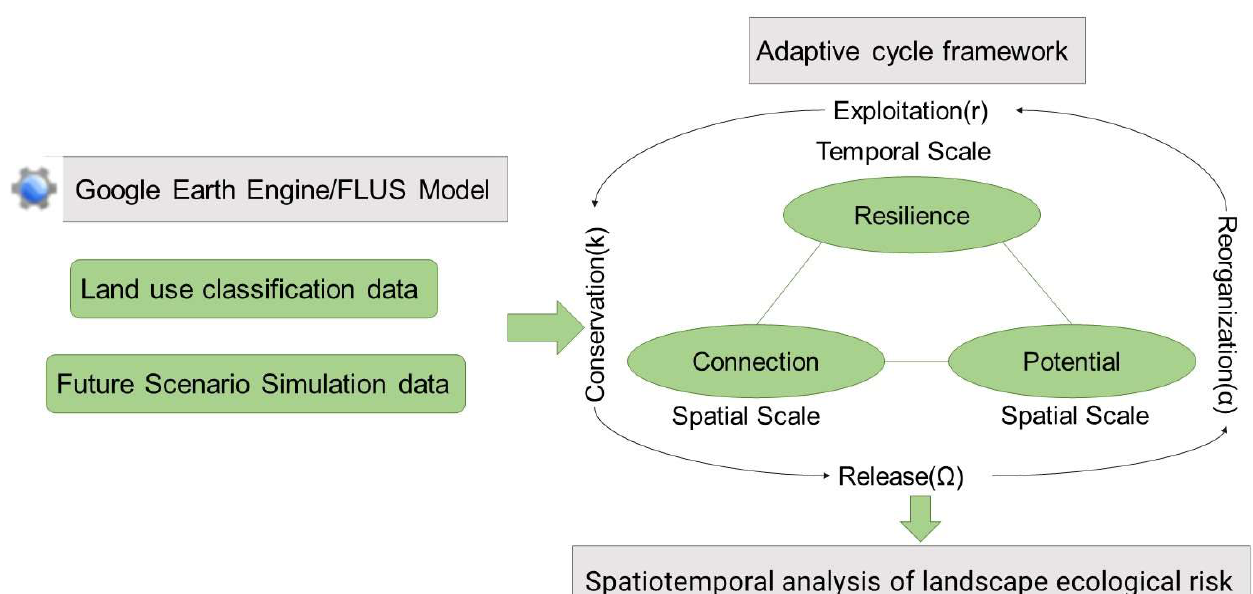
Figure 3. Technical route.